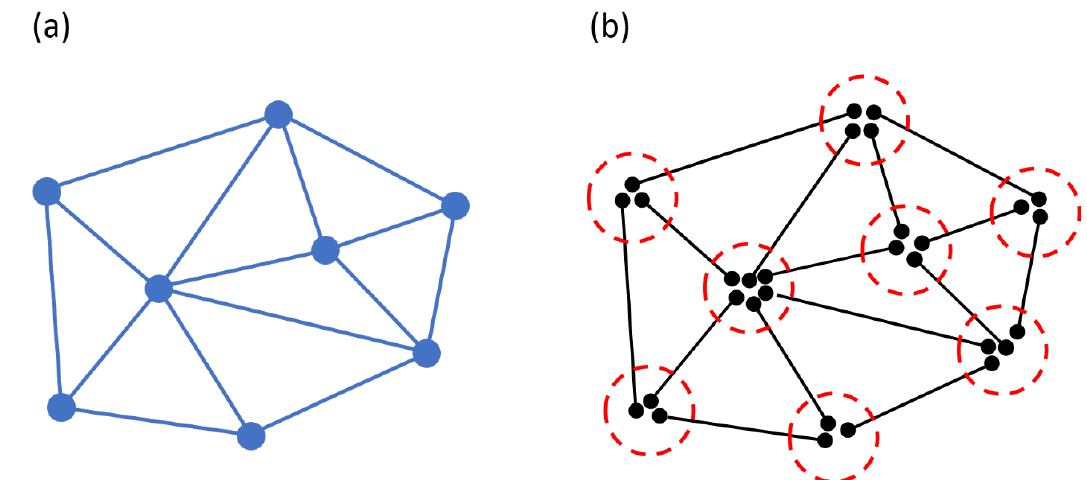
Figure 5 . (a) A graph G = ( V, E ) is shown in blue. (b) A representation of the link state Each line with a dot at each end represents an EPR pair, with the dots corresponding to qudits. The dotted red circles designate the collections of qudits corresponding to vertices v of the graph G . The number of qudits at a vertex of the graph is the same as the degree of that